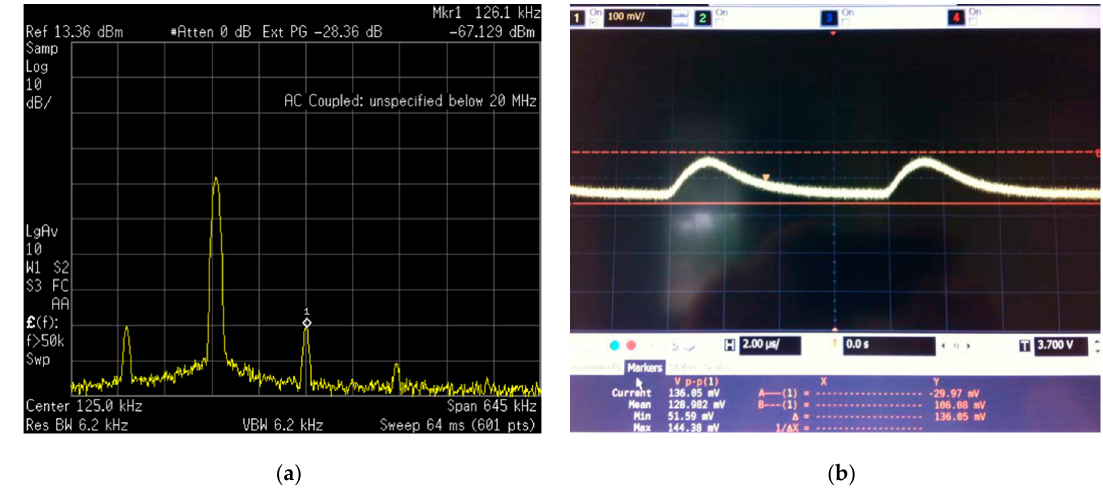
Figure 5. Output of the WuR in the discrete spectrum analyser for a − 40 dBm AM input signal ( a ) and output of the WuR in the time domain ( b ).